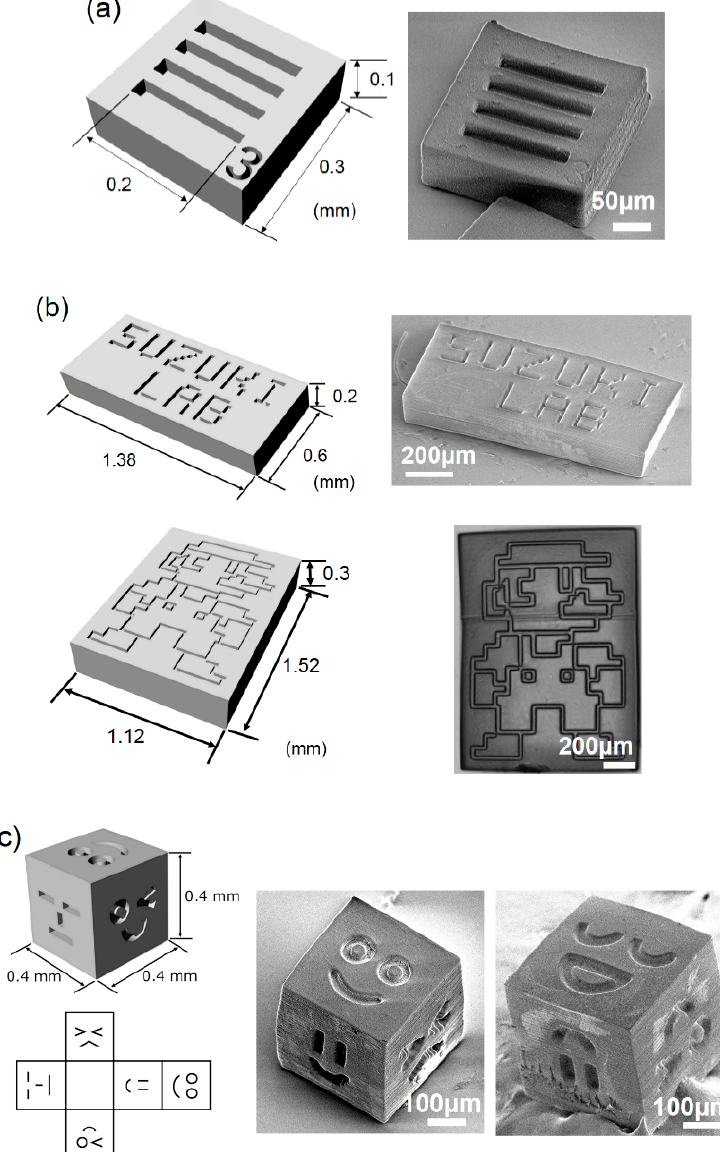
Figure 2. Design and real images of template components fabricated by micro stereolithography. ( a ) Square template with four straight trenches used for determining polyethylene glycol (PEG) concentration. ( b ) Rectangular flat plates with designed trenches (alphabetic letters and a game character). ( c ) A cube structure of different faces on five sides.